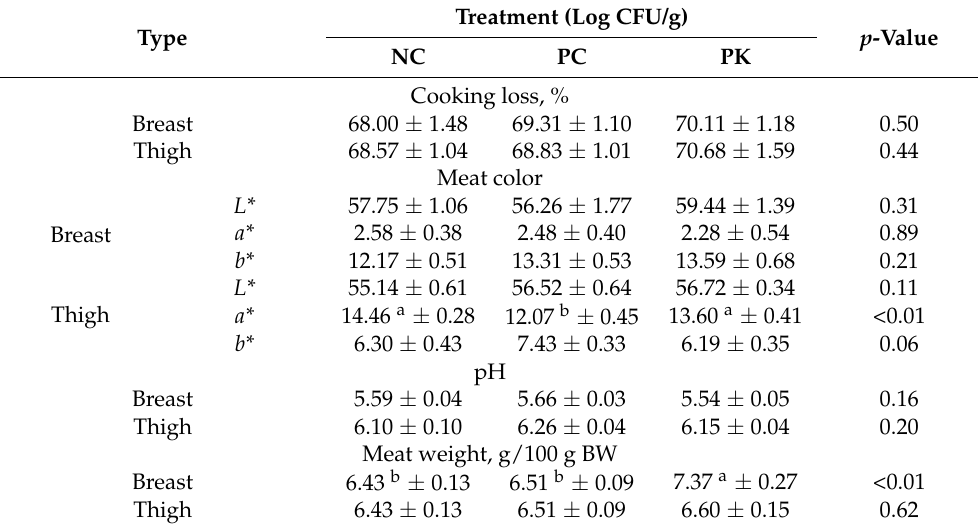
Table 6. Dietary supplemental effect of P. konkukensis on meat quality in